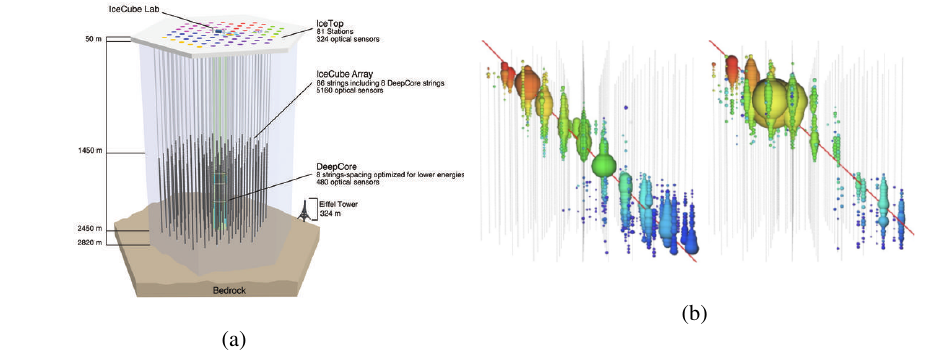
Figure 2: Fig (a) shows the setup of the IceCube Observatory. There are approximately 5000 Digital Optical modules (DOMs) placed within the Antarctic ice. Fig (b) shows the pattern of light deposition for signal and background. The colored bubbles indicate the relative time of arrival of light, with red being earliest and blue being the latest. The size of the bubbles is proportional to the number of photons. To the left, the pattern is more uniformly distributed, which is indicative of a background event produced by atmospheric muons. The pattern in the right figure has a large stochastic energy deposition which is indicative of a signal due to a muon produced from an astrophysical